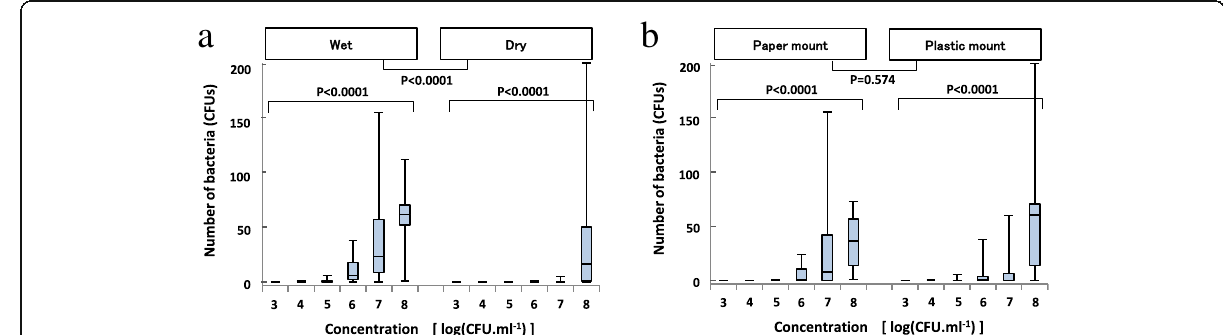
Fig. 4 a Contamination of the needle hub in the push-off top method (wet/dry). b Contamination of the needle hub in the push-off top method